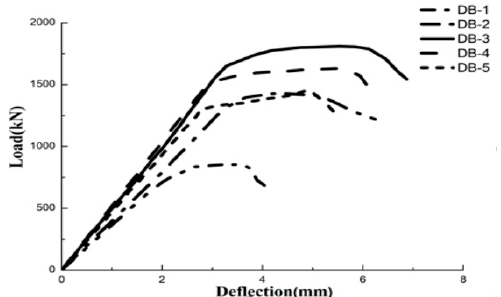
Figure 9. Relationship between the load and mid-deflection.